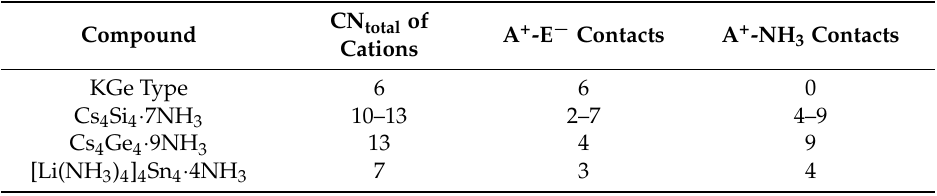
Table 7. Coordination number of the cations in KGe and related